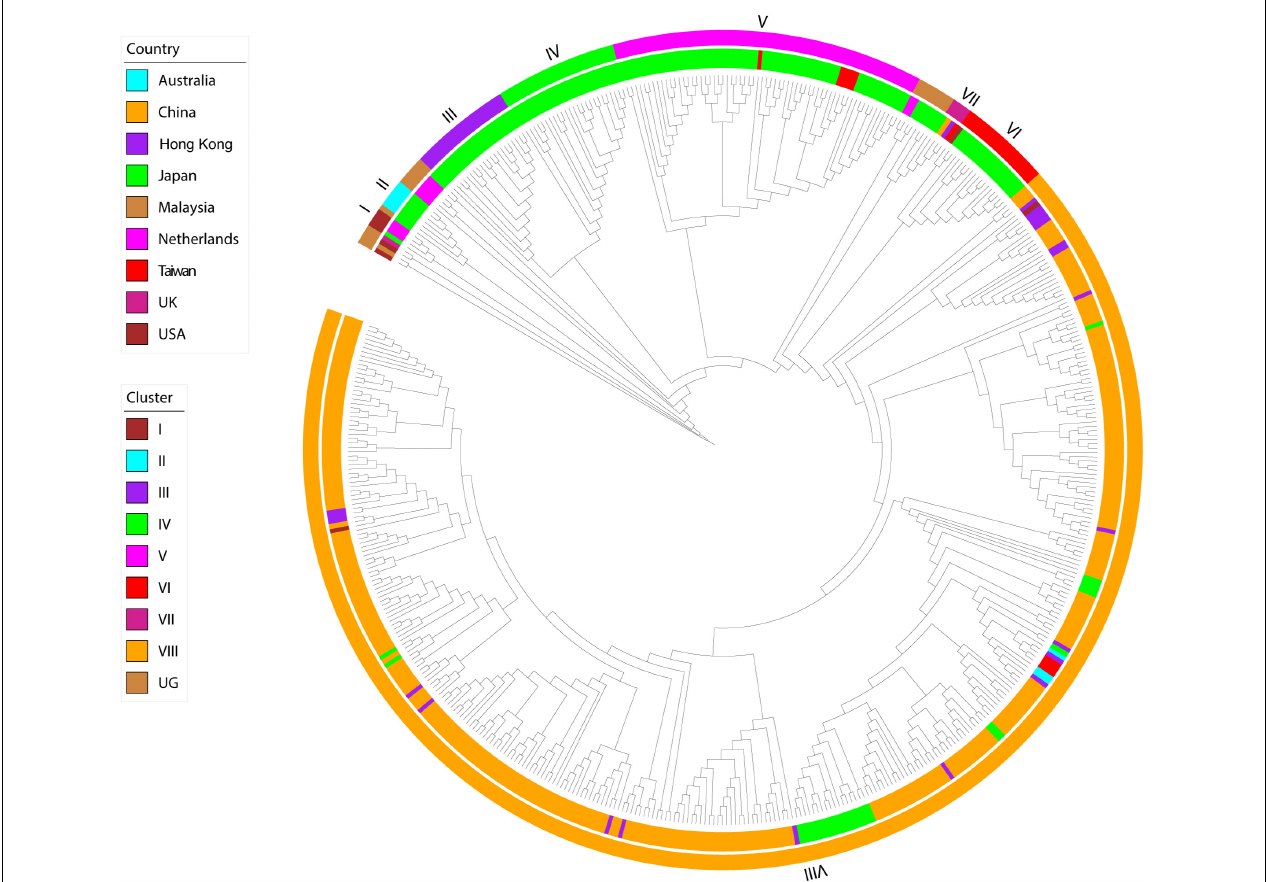
FIGURE 1 | Maximum-likelihood phylogeny of HuNoV GII.2 strains. The two circles of color show geographic location (inner) and phylogenetic cluster (outer).